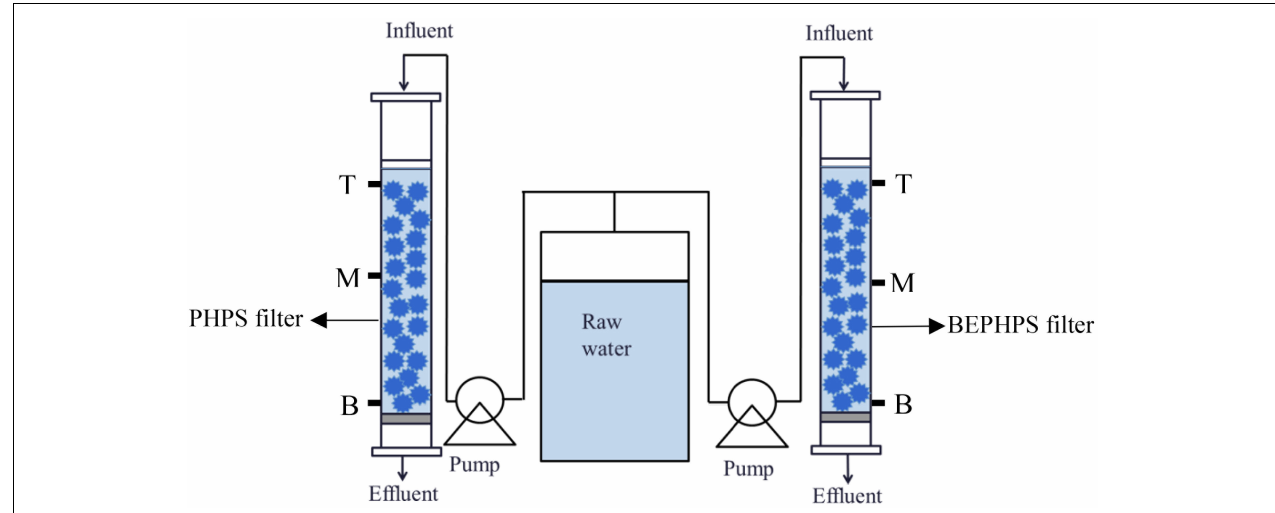
FIGURE 1 | Schematic diagram of the BEPHPS filter used for the water treatment